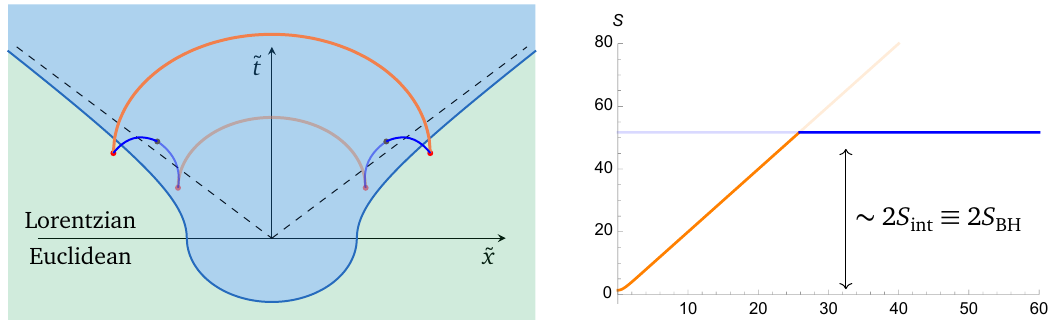
Figure 12: Left : the system in the planar thermofield double state (in Lorentzian signature). The brane (dark blue) becomes an hyperboloid, and the red dots during the dynamics follow hyperbolic trajectories. The orange RT surfaces are dominant at early times, and the entropy increases linearly. The blue RT surfaces are dominant at late times, and the entropy is constant. Such geodesics are the corresponding island saddle in the two dimensional perspective. Right : the dynamics of the entanglement entropies in time corresponding to the different RT surfaces (orange and blue), in the cylinder coordinates. The total entanglement entropy is always the smaller be- tween (4.23) and (4.25), thus it increases (approximately) linearly until it saturates = 6, at (approximately) twice of the interface entropy. In this plot we have chosen c I ∗ + ρ ∗ = 12, β = 2 π , u = 1, (cid:34) = 1 and ρ = I II c II 0 2 G ( 3 )